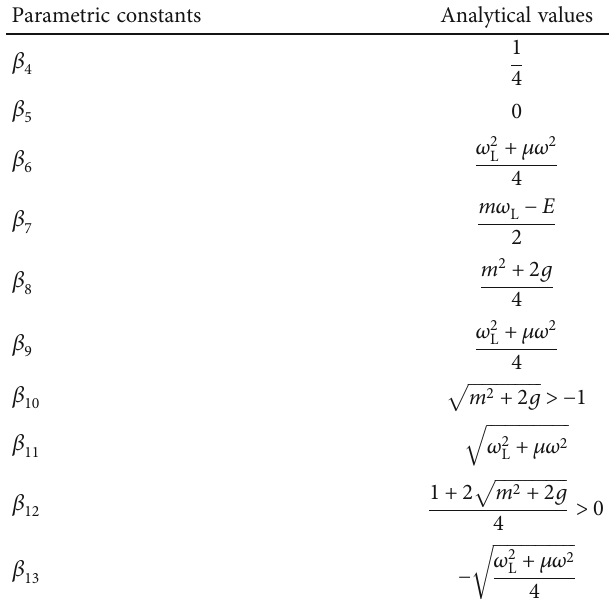
Table 2: The values of parametric constants required for the derivation of energy eigenvalues and